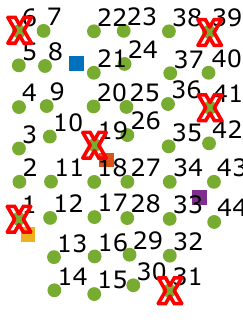
Figure 6. Points used in the calibration